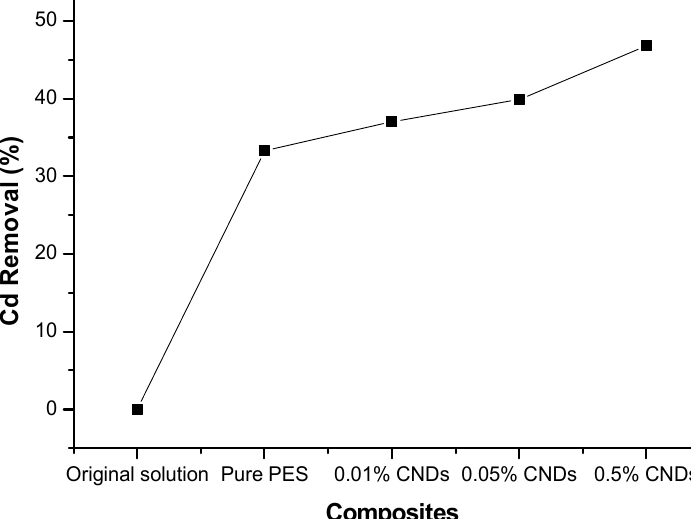
Figure 9. Effect of different membrane composition for the removal of cadmium(II) from standard solutions.